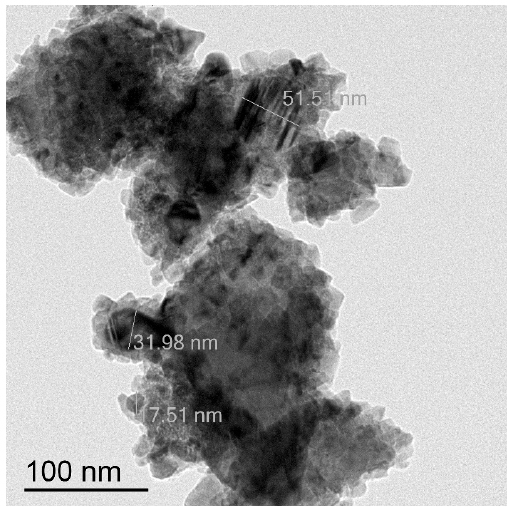
Figure 4. TEM image of CuNPs of the average particles size 10/80 nm.